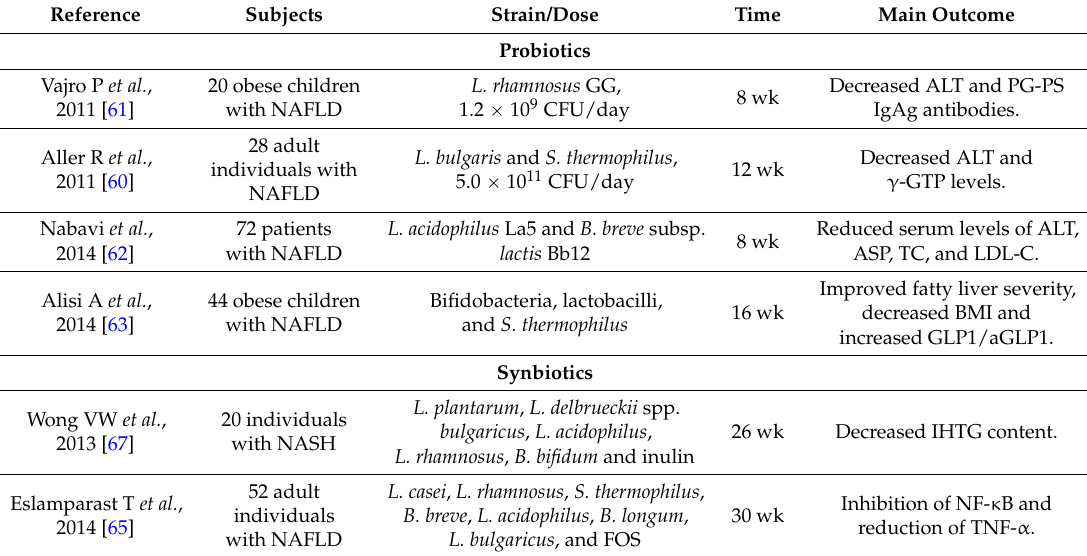
Table 4. Summary of randomized clinical intervention trials of probiotics and synbiotics in non-alcoholic fatty liver